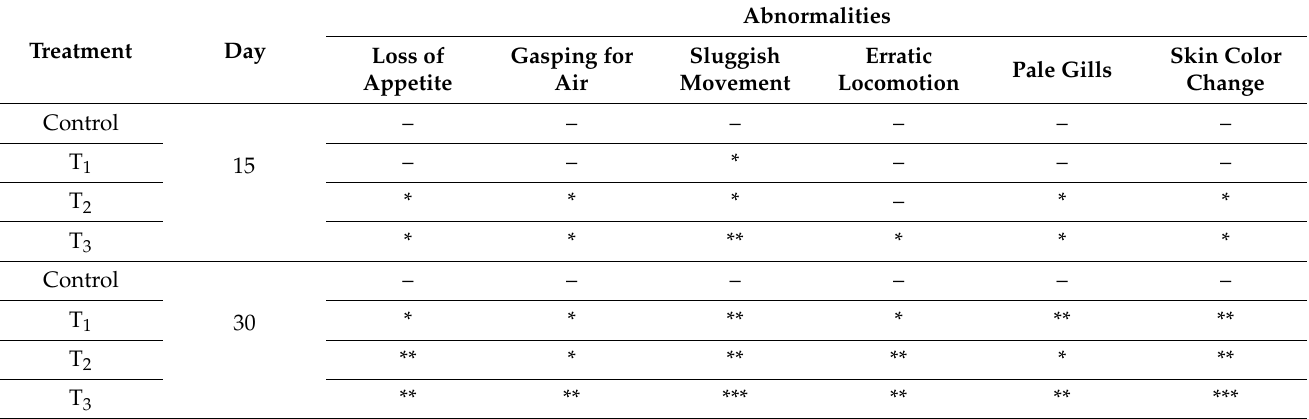
Table 5. Behavioural abnormalities of fishes among the different treatment units.